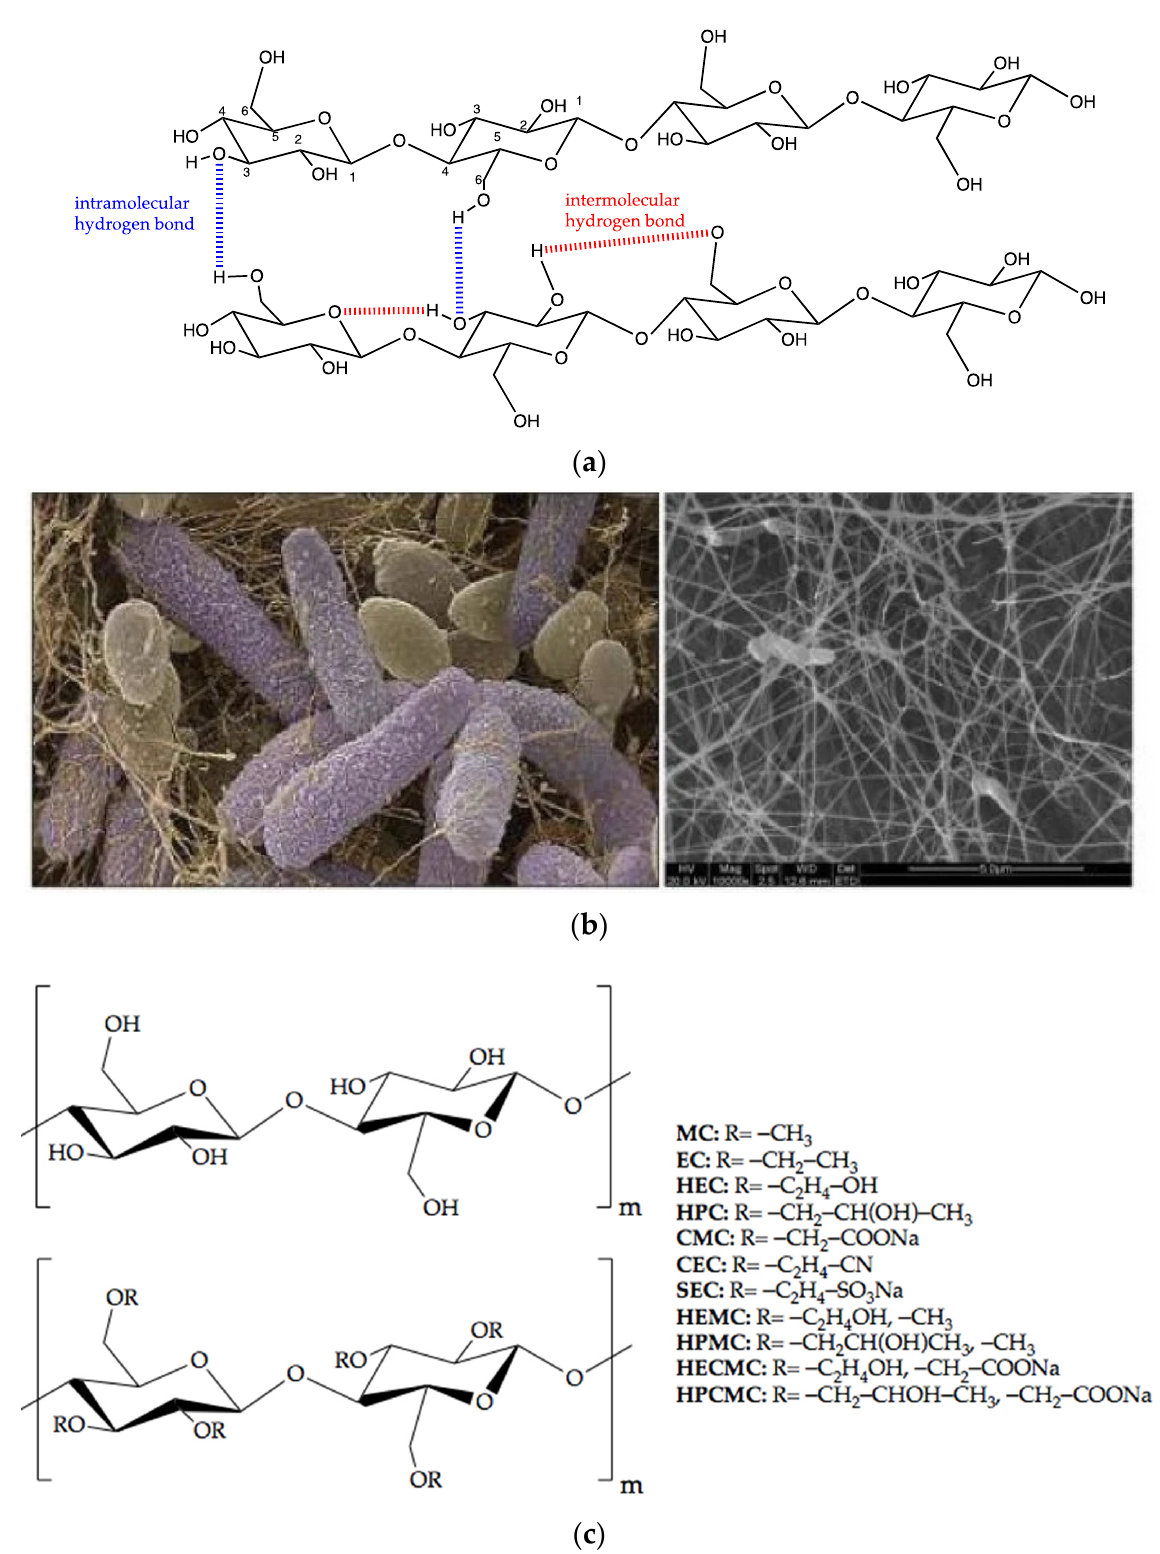
Figure 2. Chemical structure of cellulose and its derivatives. ( a ) Chemical structure of cellulose. ( b ) Scanning electron micrograph images of Acetobacter xylinum and formation of bacterial cellulose. Adapted with permission from Ref. [43] Copyright 2019, Springer Nature. ( c ) The chemical structure of cellulose and some of its derivatives. Adapted with permission from Ref. [54] Copyright 2016, WILEY-VCH Verlag GmbH & Co. KGaA, Weinheim.